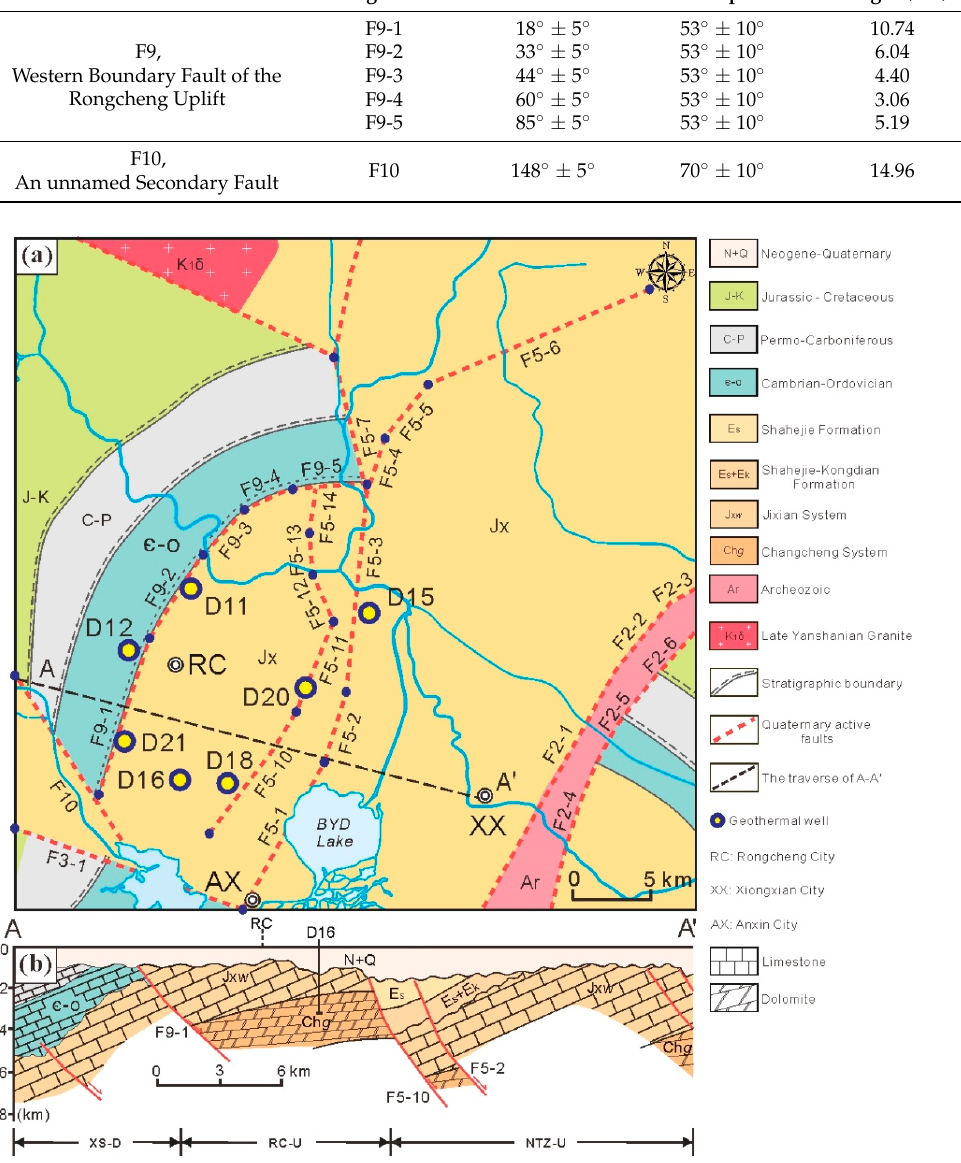
Figure 2. Geological structures of bed rock and the Middle-Late Pleistocene active faults in the Rongcheng deep geothermal reservoir region. ( a ) Simplified segments of the Middle-Late Pleistocene active faults in the Rongcheng deep geothermal reservoir region (modified from [24,31]). ( b ) Geological profile of the Rongcheng deep geothermal reservoir (modified from [31]). Table 1. The attribute parameters of the main active faults in the Rongcheng deep geothermal res- ervoir.